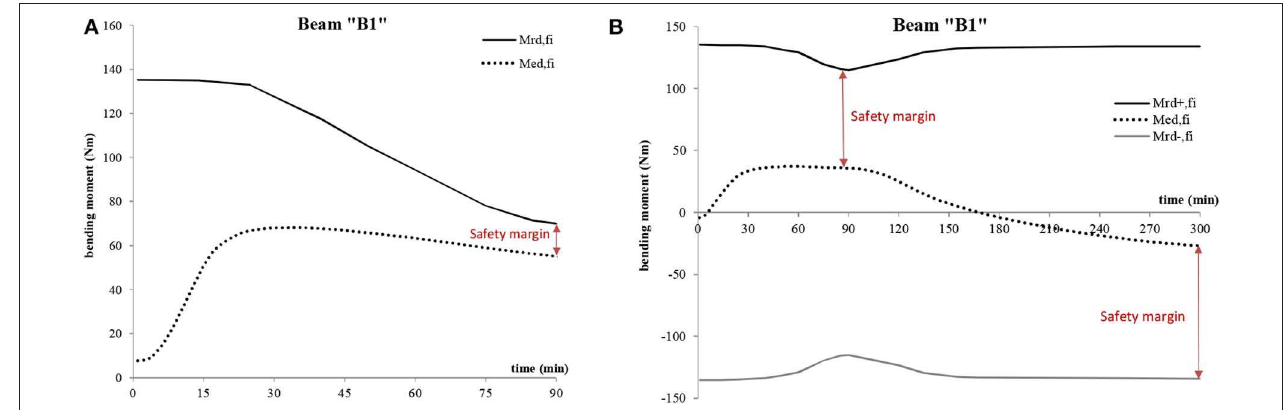
FIGURE 13 | (A) Stress and strain on beam “B1” with ISO834 fire. (B) Stress and strain on beam “B1” with library fire